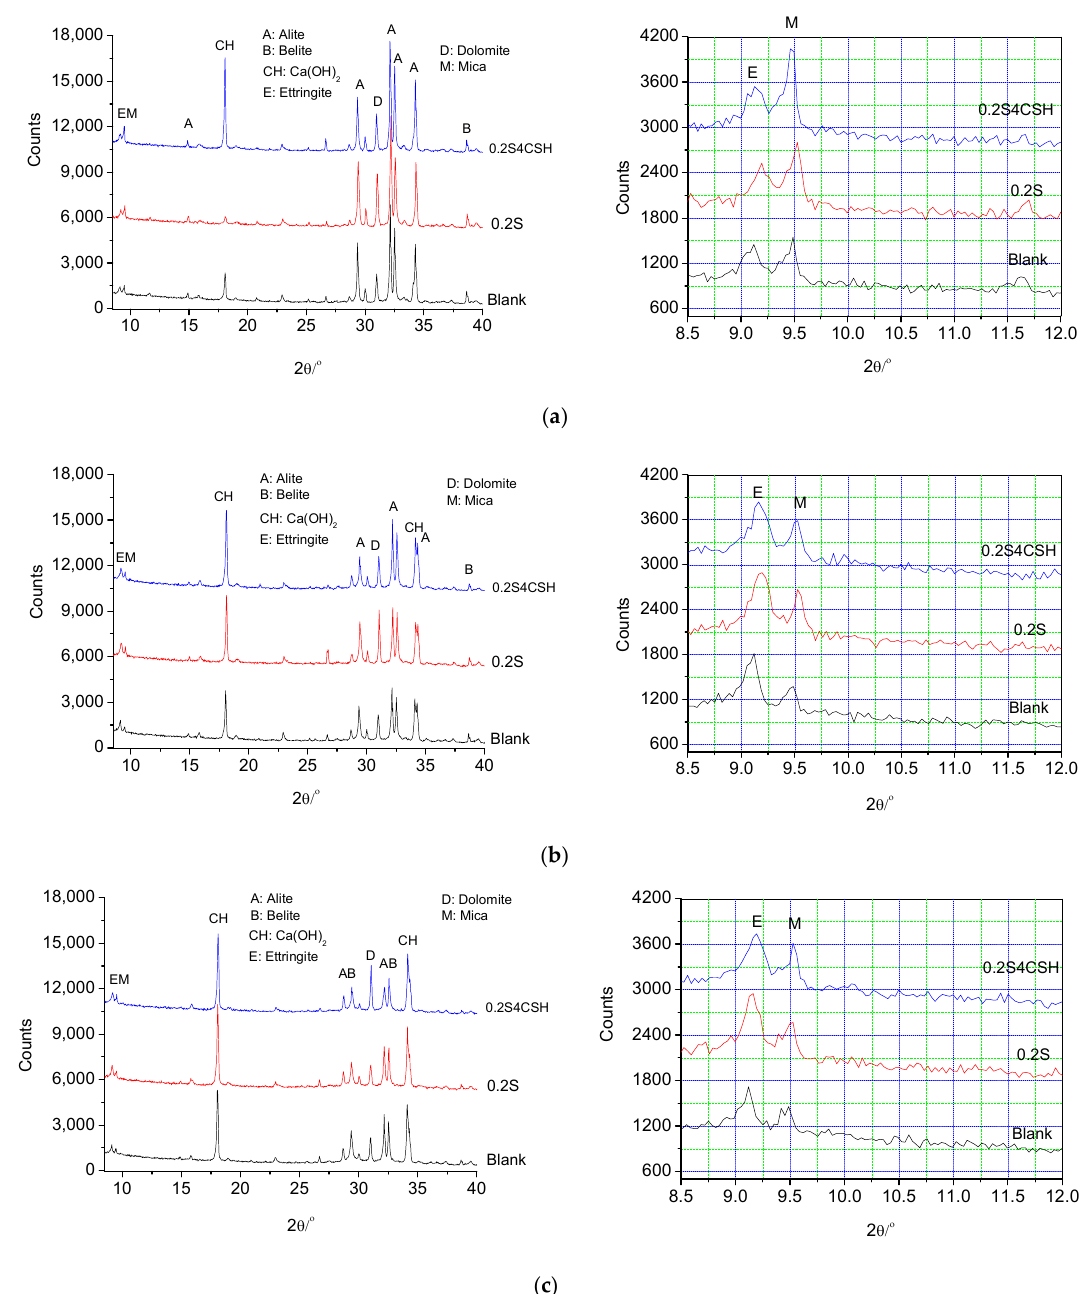
Figure 11. XRD diagrams of the hardened cement paste (HCP) with and without sucrose (0.2 wt.%) and the nano-C-S-H gel (4.0 wt.%) addition at ( a ) T1, ( b ) T2, ( c ) T3. However, for the paste with both 0.2 wt.% sucrose and 4.0 wt.% C-S-H gel addition, it is